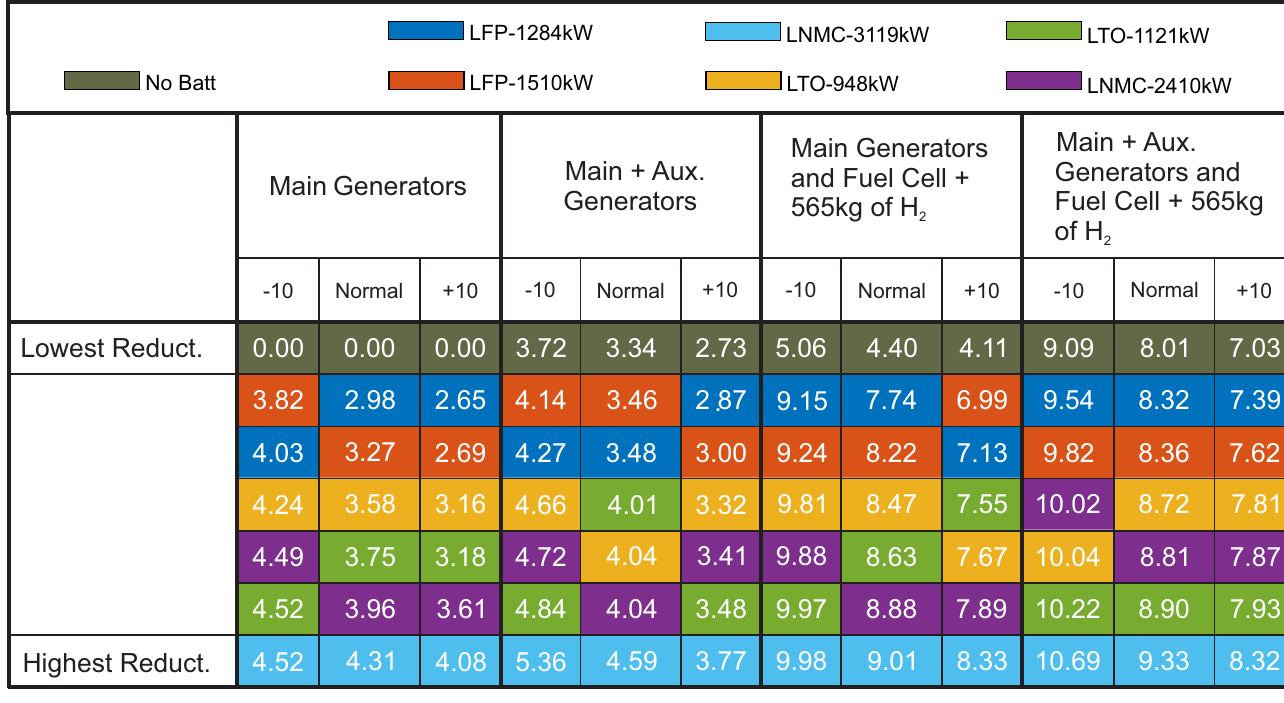
Figure 14. Compilation of the emission reductions achieved by configurations analyzed in this paper, except those including 278kg and 486kg of hydrogen. The highest and lowest emission reductions are highlighted, numbers are shown as